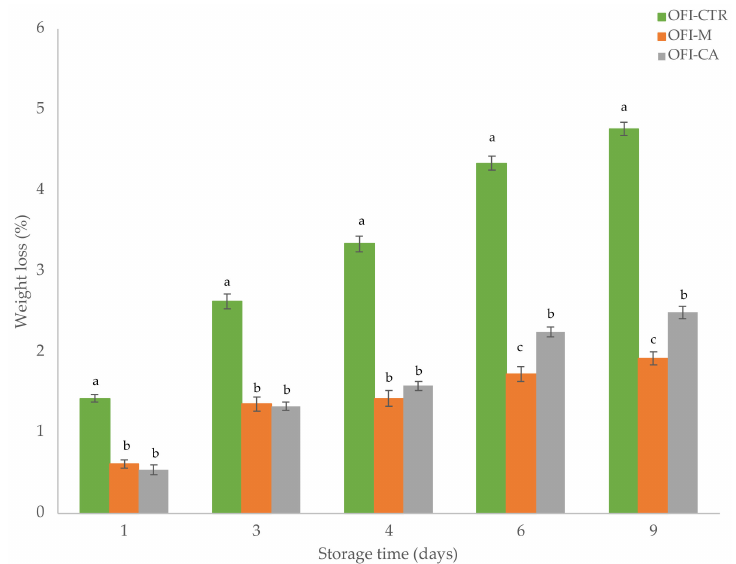
Figure 1. Changes in weight loss (%) in minimally processed O. ficus-indica fruits non-treated (OFI- CTR) and treated with mucilage (OFI-M) and calcium ascorbate coating (OFI-CA) during cold storage (9 days at 5 ◦ C). Different lowercase letters indicate significant differences between the treatments in each sampling date. Data are the mean ± SE (Vertical bars represent standard error; n =